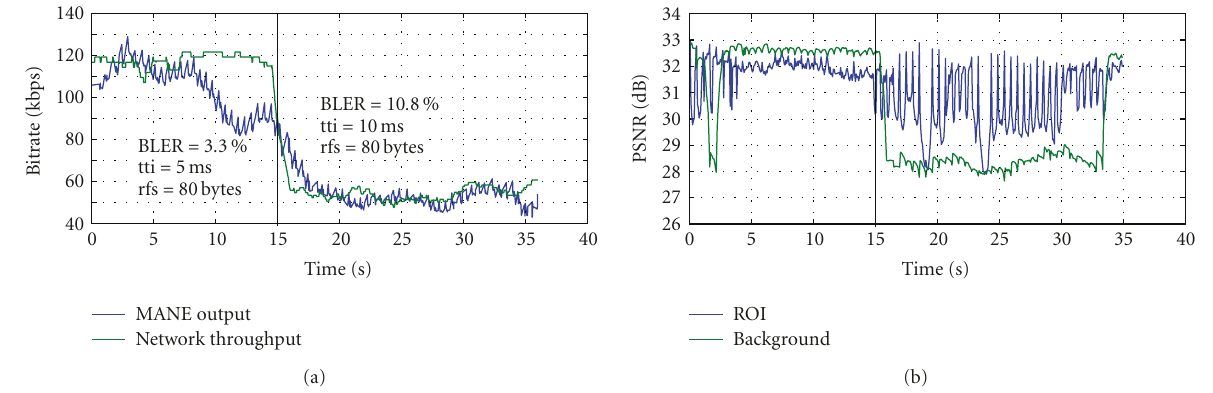
Figure 12: Bitrate adaptation with 3 RTP streams: quality base layer, SNR refinement for ROI, and SNR refinement for background (“Paris” sequence).